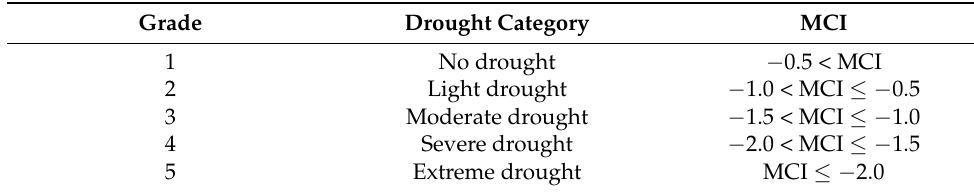
Table 1. Categorization of drought by